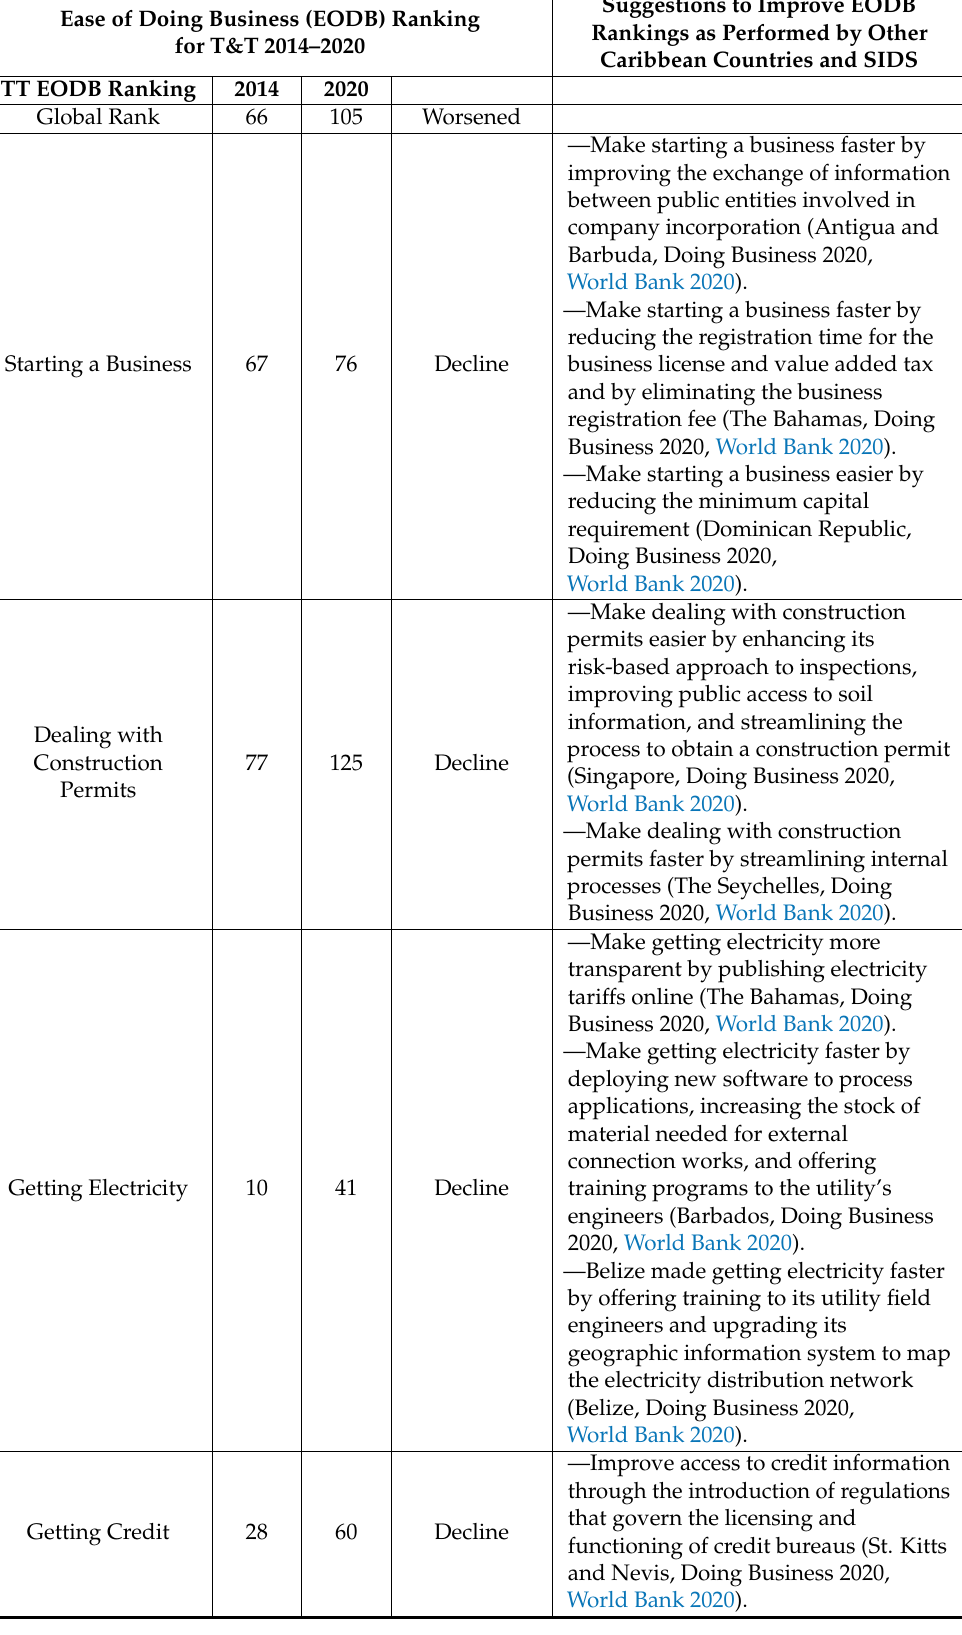
Table A5. Measures that can be adopted to improve the EODB pillars in